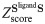
Values of ZscoreSligandS for different ligands.